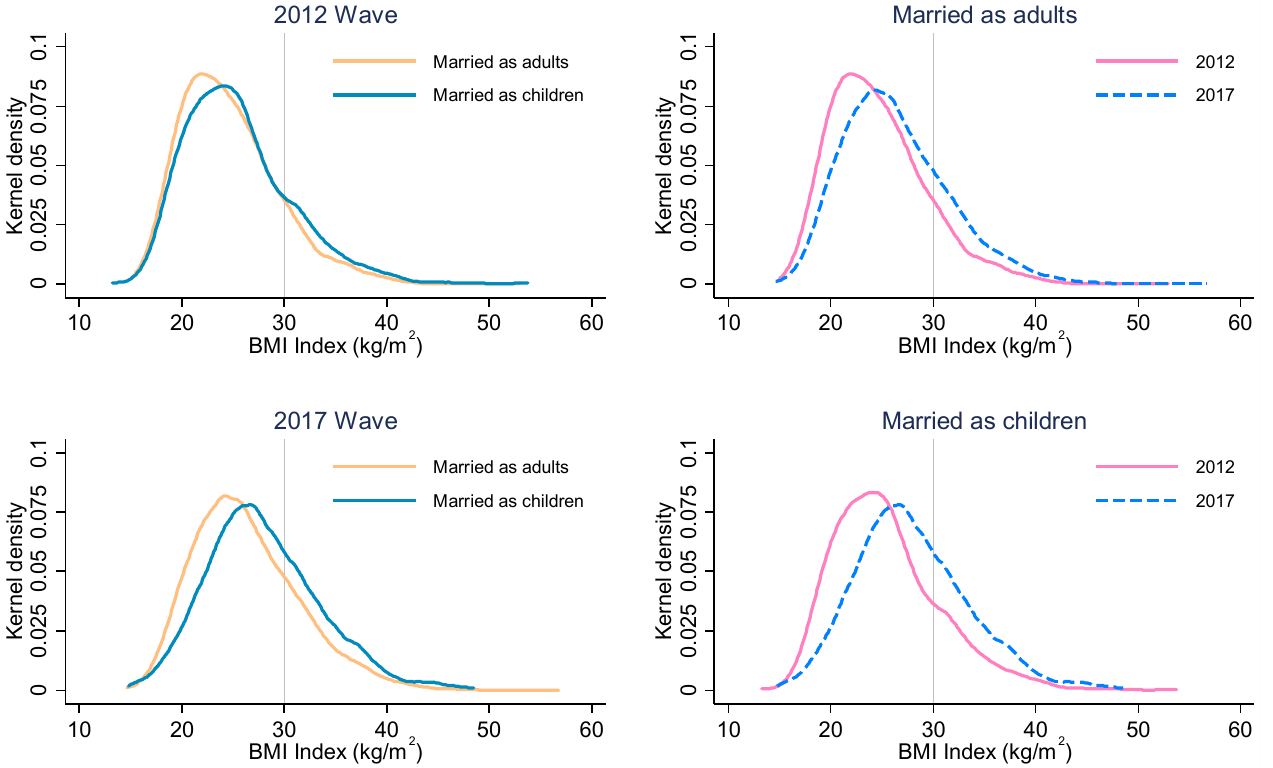
Figure 2. Distribution of body mass index by child marriage and survey wave. Figure 3 shows the obesity prevalence by survey waves and birth cohorts, and the differences in obesity prevalence by child marriage within the birth cohorts in respective survey waves. The differences between the two groups were more apparent in the younger birth cohorts during the 2017 survey wave. The differences, however, were not statistically significant for the older birth cohorts. The BMI distributions, in box plots, across birth cohorts by child marriage and survey waves are presented in Figure 4. In each birth cohort, particularly during the 2017 wave, the median levels of BMI for women married as children were higher than those of their counterparts married as